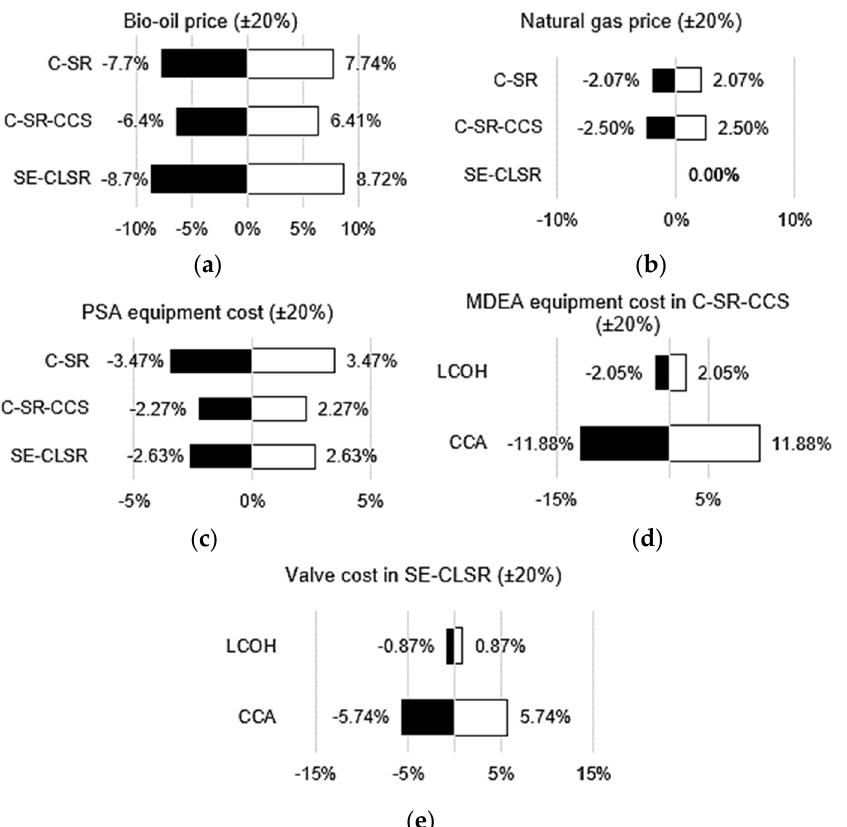
Figure 9. Various economic sensitivity analyses: ( a ) effect of bio-oil price on LCOH; ( b ) effect of natural gas price on LCOH; ( c ) effect of PSA equipment cost on LCOH; ( d ) effect of MDEA cost on LCOH and CCA for C-SR-CCS; ( e ) effect of valve cost on LCOH and CCA for SE-CLSR.